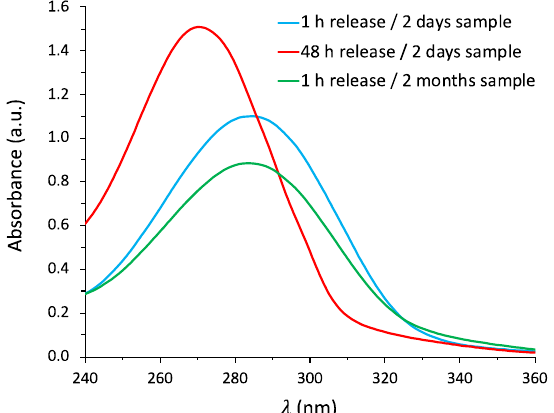
Figure 4. UV–vis spectra of released CIN during tests performed on TO-APTES-CIN after 2 days and 2 months of aging. The spectrum of released CIN after 48 h is also reported as a reference.